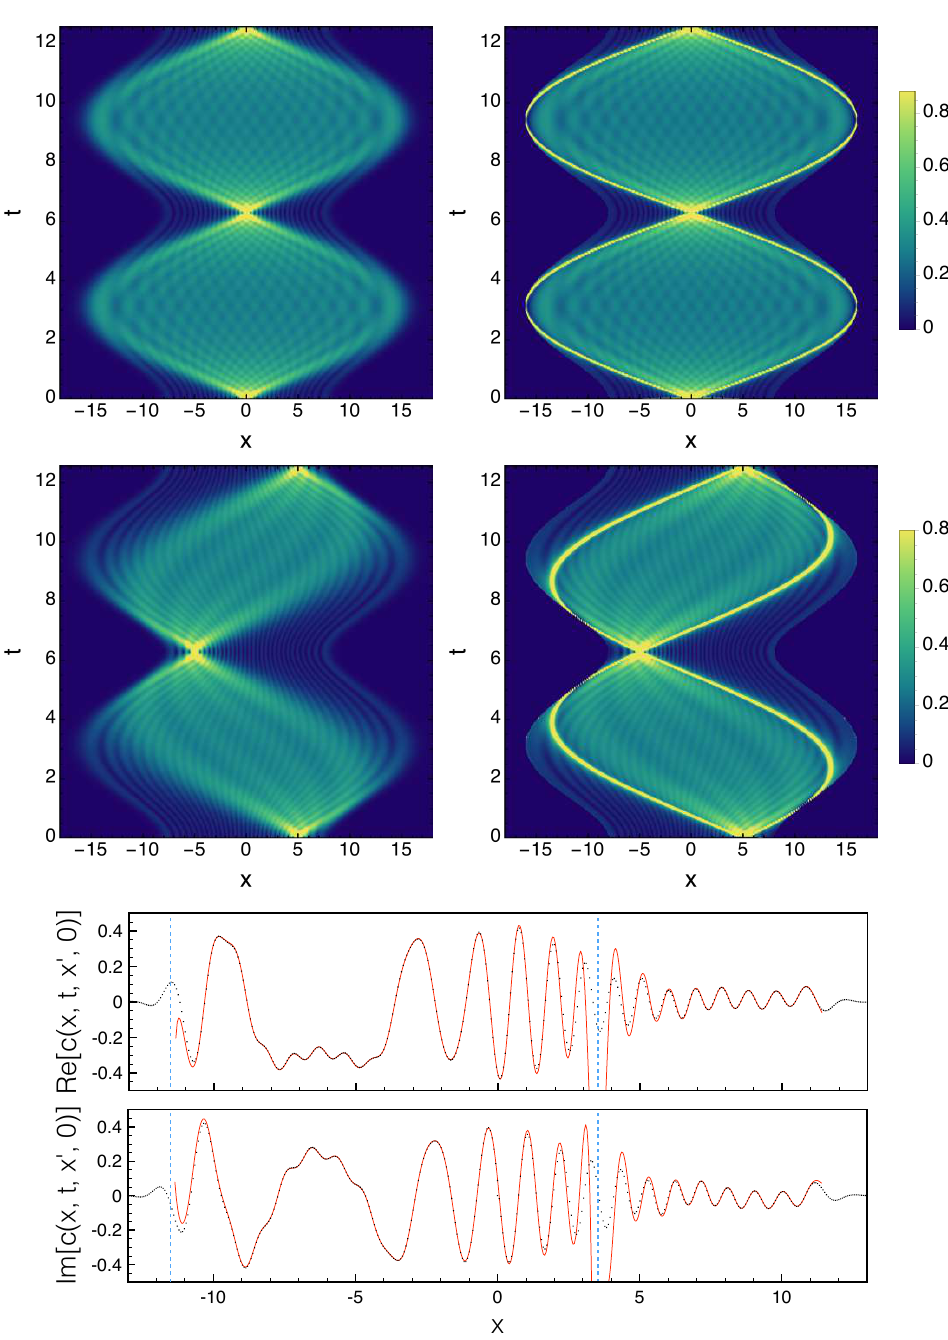
Figure 9: Fermionic propagator, c ( x , t , x (cid:48) ,0 ) , Eq.(55), as a function of x and t , for fixed values of x (cid:48) . In the density plots the absolute value is shown. Upper row: x (cid:48) = 0. Lower row: x (cid:48) = 5. Left: Exact function from scaling approach, Eq. (73). Right: Our prediction, Eq. (68). The one dimensional plots below show the real and the imaginary part of c ( x , t , x (cid:48) ,0 ) as a function of x , with x (cid:48) = 5 and fixed t = 5. The black dots are the exact function from scaling approach, Eq. (73). The red line is our prediction, Eq. (68). The dashed vertical lines are the positions of the lightcone. = 1, ω = 0.5, N = The parameters are chosen as follows: ω 0 1